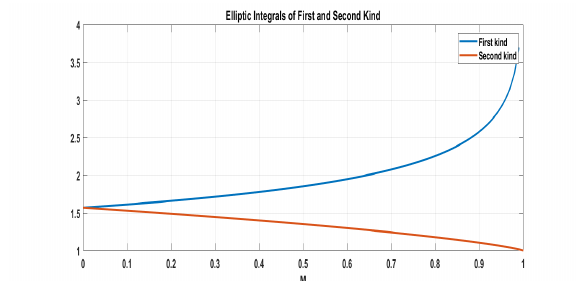
Figure 5. Complete elliptical integrals of the first and second kinds.